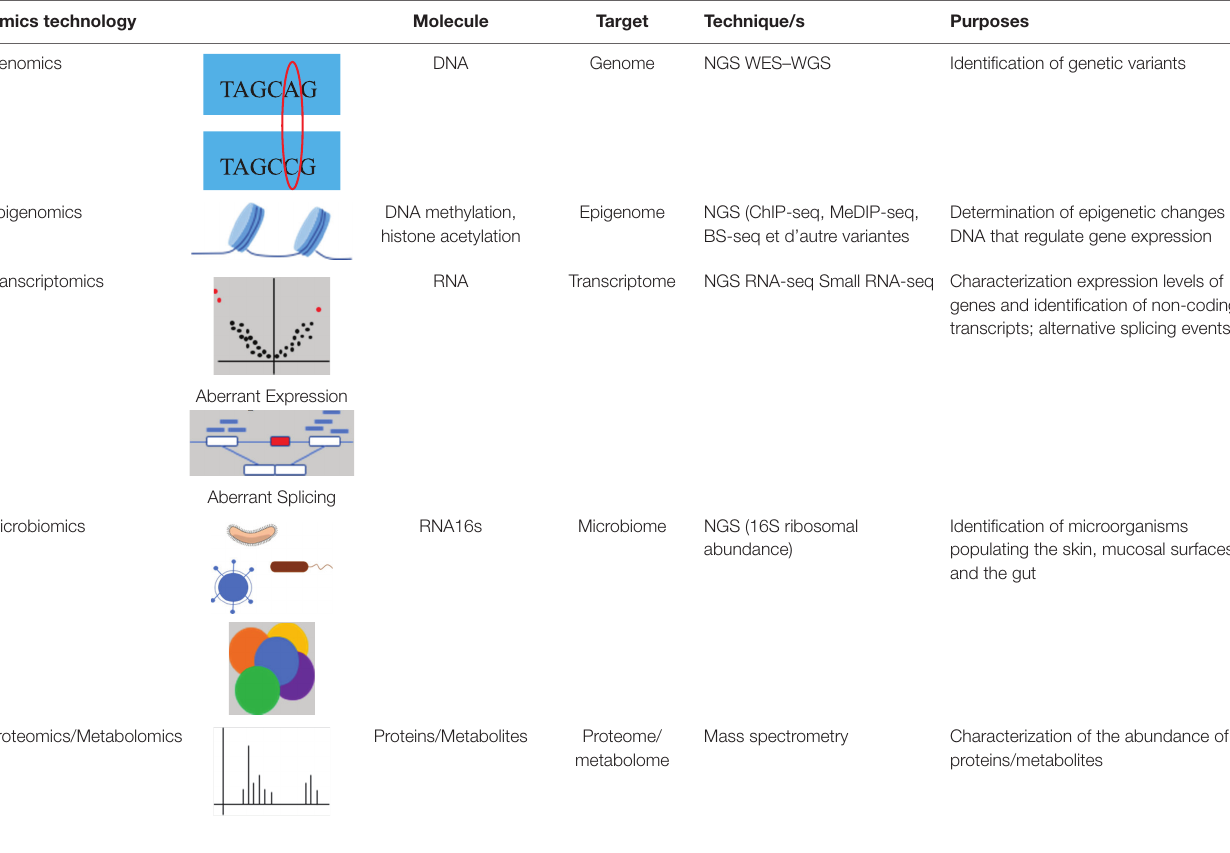
TABLE 1 | Different omics technologies and their characteristics: molecule targeted, omics targeted, sequencing techniques, and their purposes. Omics